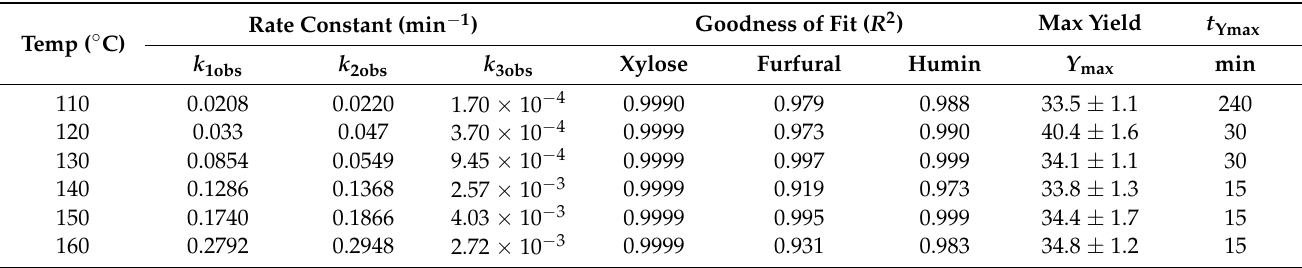
Table 2. Fitted reaction parameters for xylose conversion into furfural in DMSO. Reaction conditions: 0.5 M Xylose, 1.0 M